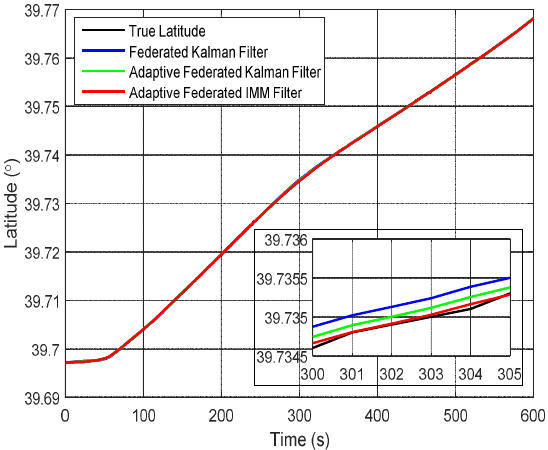
Sensors 2020 , 20 , x FOR PEER REVIEW Figure 17. The estimation curves of latitude. Figure 17. The estimation curves of latitude.